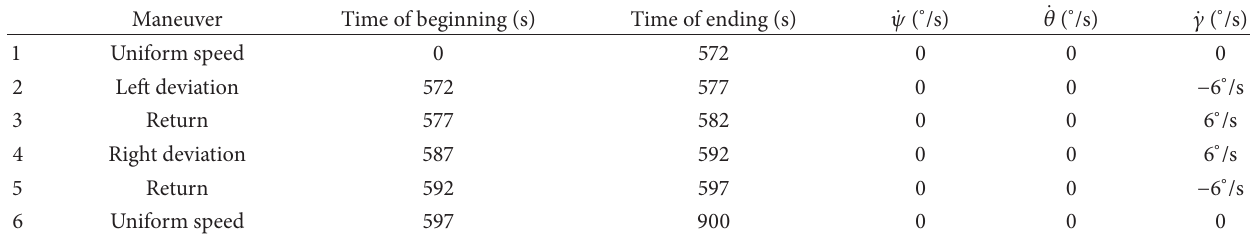
Table 1: Simulation trajectory of